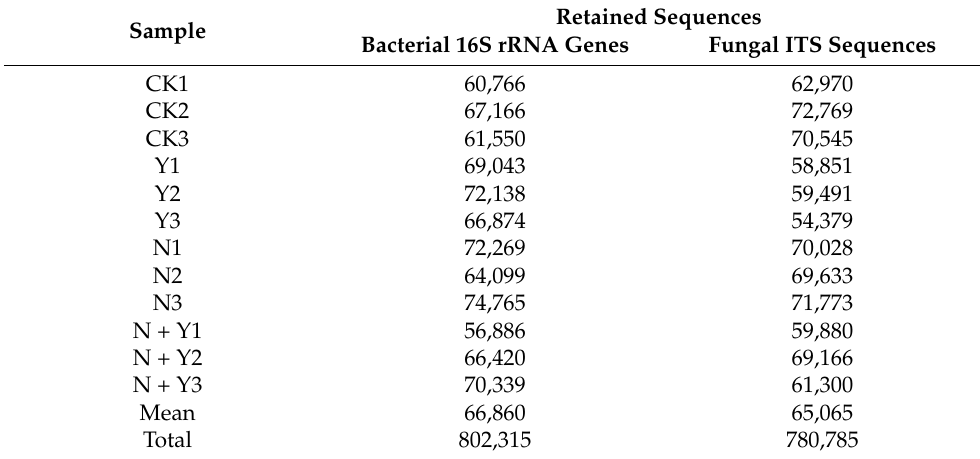
Table 5. Retained sequences that were used for further analysis after removing the short, ambiguous, and low-quality reads of the rhizospheric samples collected from different